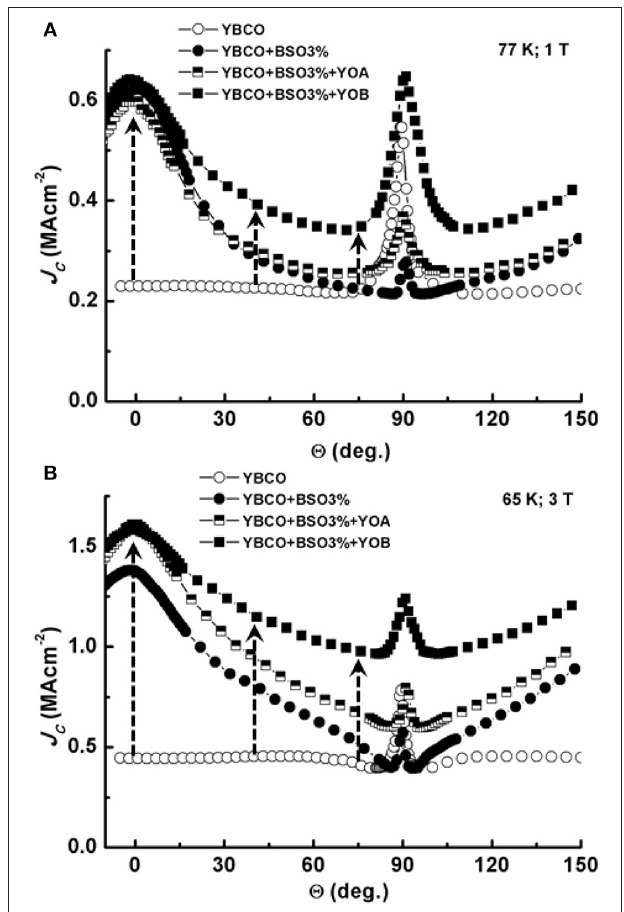
FIGURE 16 | Angular variation of J c for pristine YBCO, YBCO YBCO BSO Y 2 O 3 nanocomposite films measured at (A) 77K, 1T, and (B) + + 65K, 3T. Two different Y 2 O 3 pieces, 2.2 area and 3 area%, are referred as YOA and YOB, respectively. Reproduced from Jha et al. [ 130], with the permission from IEEE